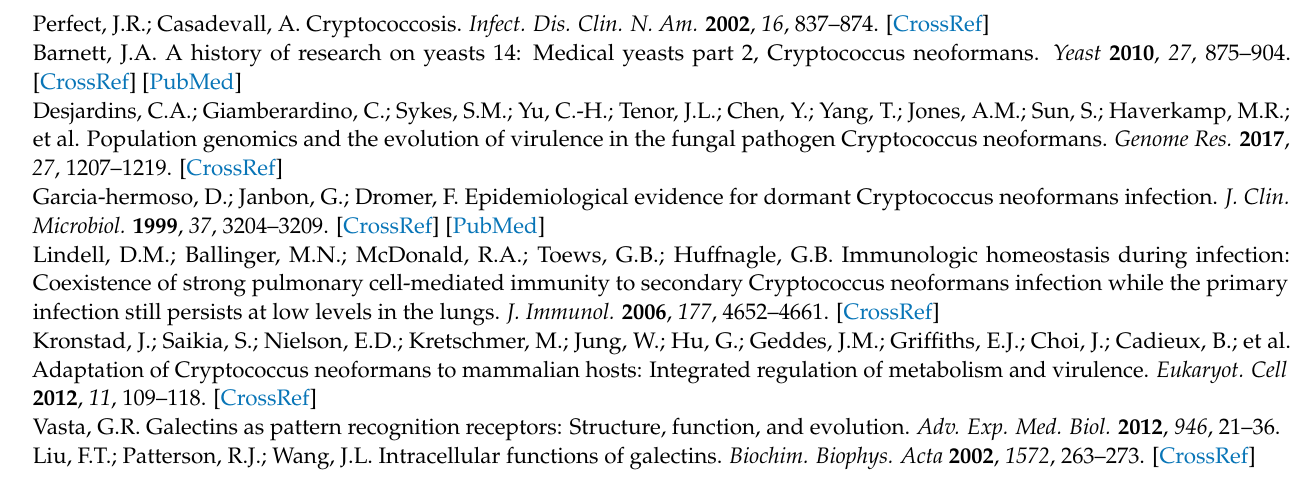
Table S2: gene expression profiles in the lungs of the WT and Gal-3 KO mice in the presence of Cryptococcus neoformans infection. Table S3: gene expression profiles in the spleens of the WT and Gal-3 KO mice in the presence of Cryptococcus neoformans infection. Table S4: gene expression profiles in the brains of the WT and Gal-3 KO mice in the presence of Cryptococcus neoformans